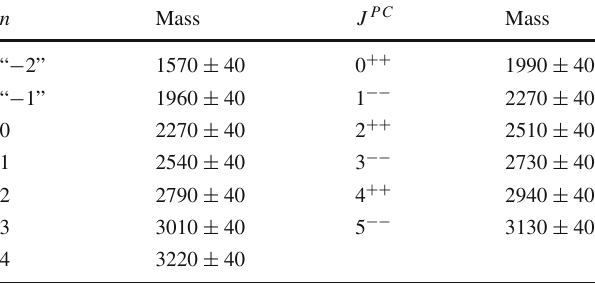
Table 13 Predictions for the states of the Y s , a tetraquark containing s ¯ s and decaying to (cid:9) ¯